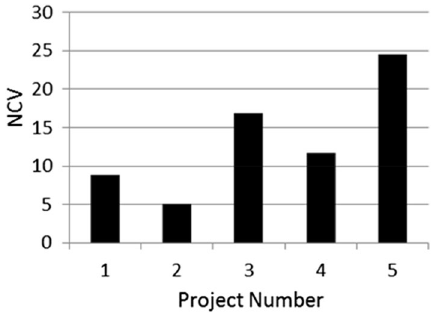
Fig. 8 NCV values for each of the five projects listed in Table 4; all have the same